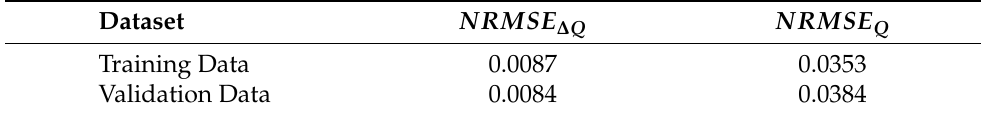
Table 5. Training and validation